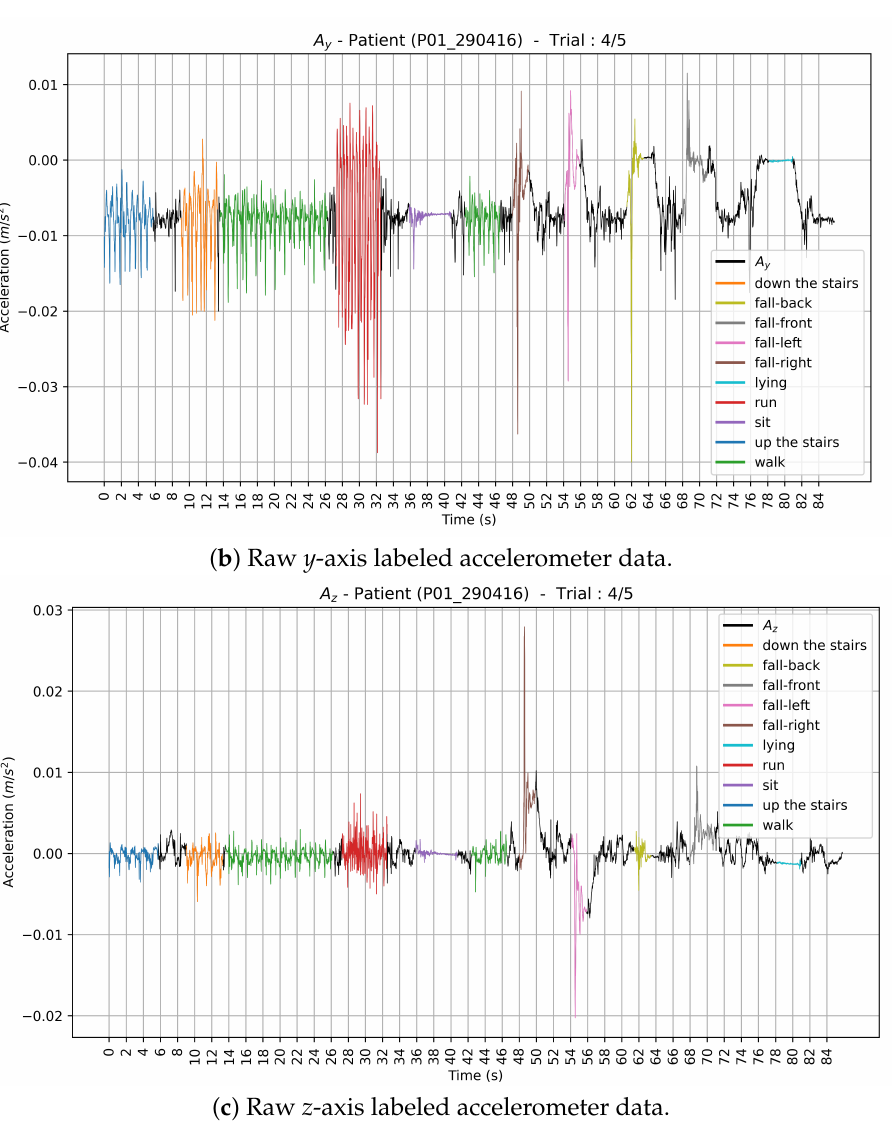
Figure 3. Plots of the raw three-axis labeled accelerometer data corresponding to one trial of a given participant (P01_290416). Each data cluster corresponding to an activity label has a different color on the